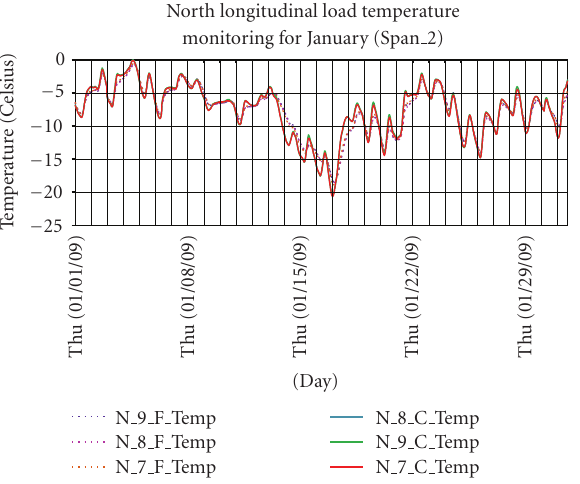
Figure 5: North longitudinal load temperature monitoring for span two (January).